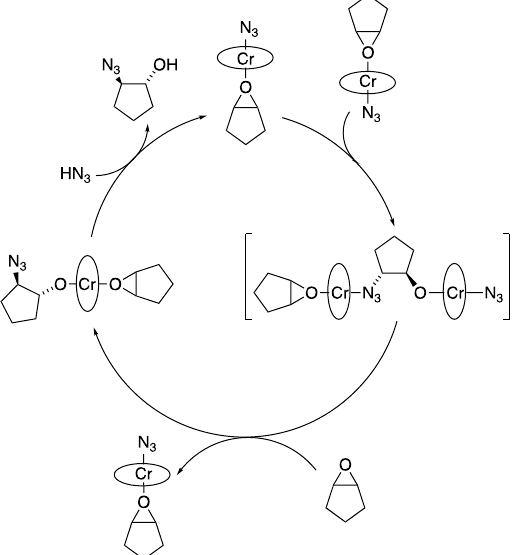
Scheme 5. The mechanism for the ARO of cyclopentene oxide with TMSN 3 catalyzed by Cr–salen complexes as proposed by Jacobsen et al. [28].